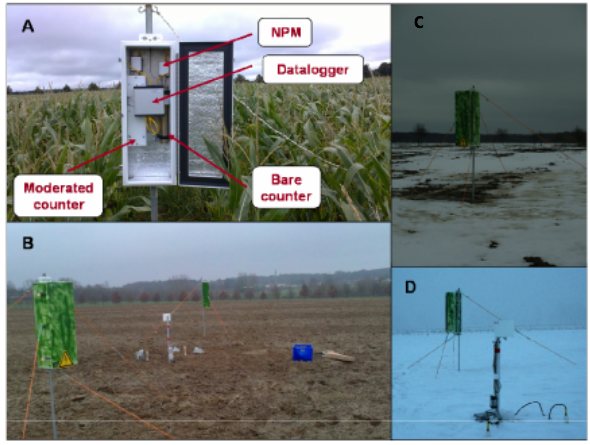
Fig. 2. Ground albedo neutron sensors (CRS-1000) under differ- ent field conditions in Bornim: (a) two-counters CRS-1000 and its parts in cropped corn field, (b) picture of two CRS-1000s in bare field condition, (c) picture of CRS-1000 at the beginning of snow cover condition, and (d) picture of CRS-1000, rain gauge and Theta Probes (MR2) during a day with maximum snow cover.